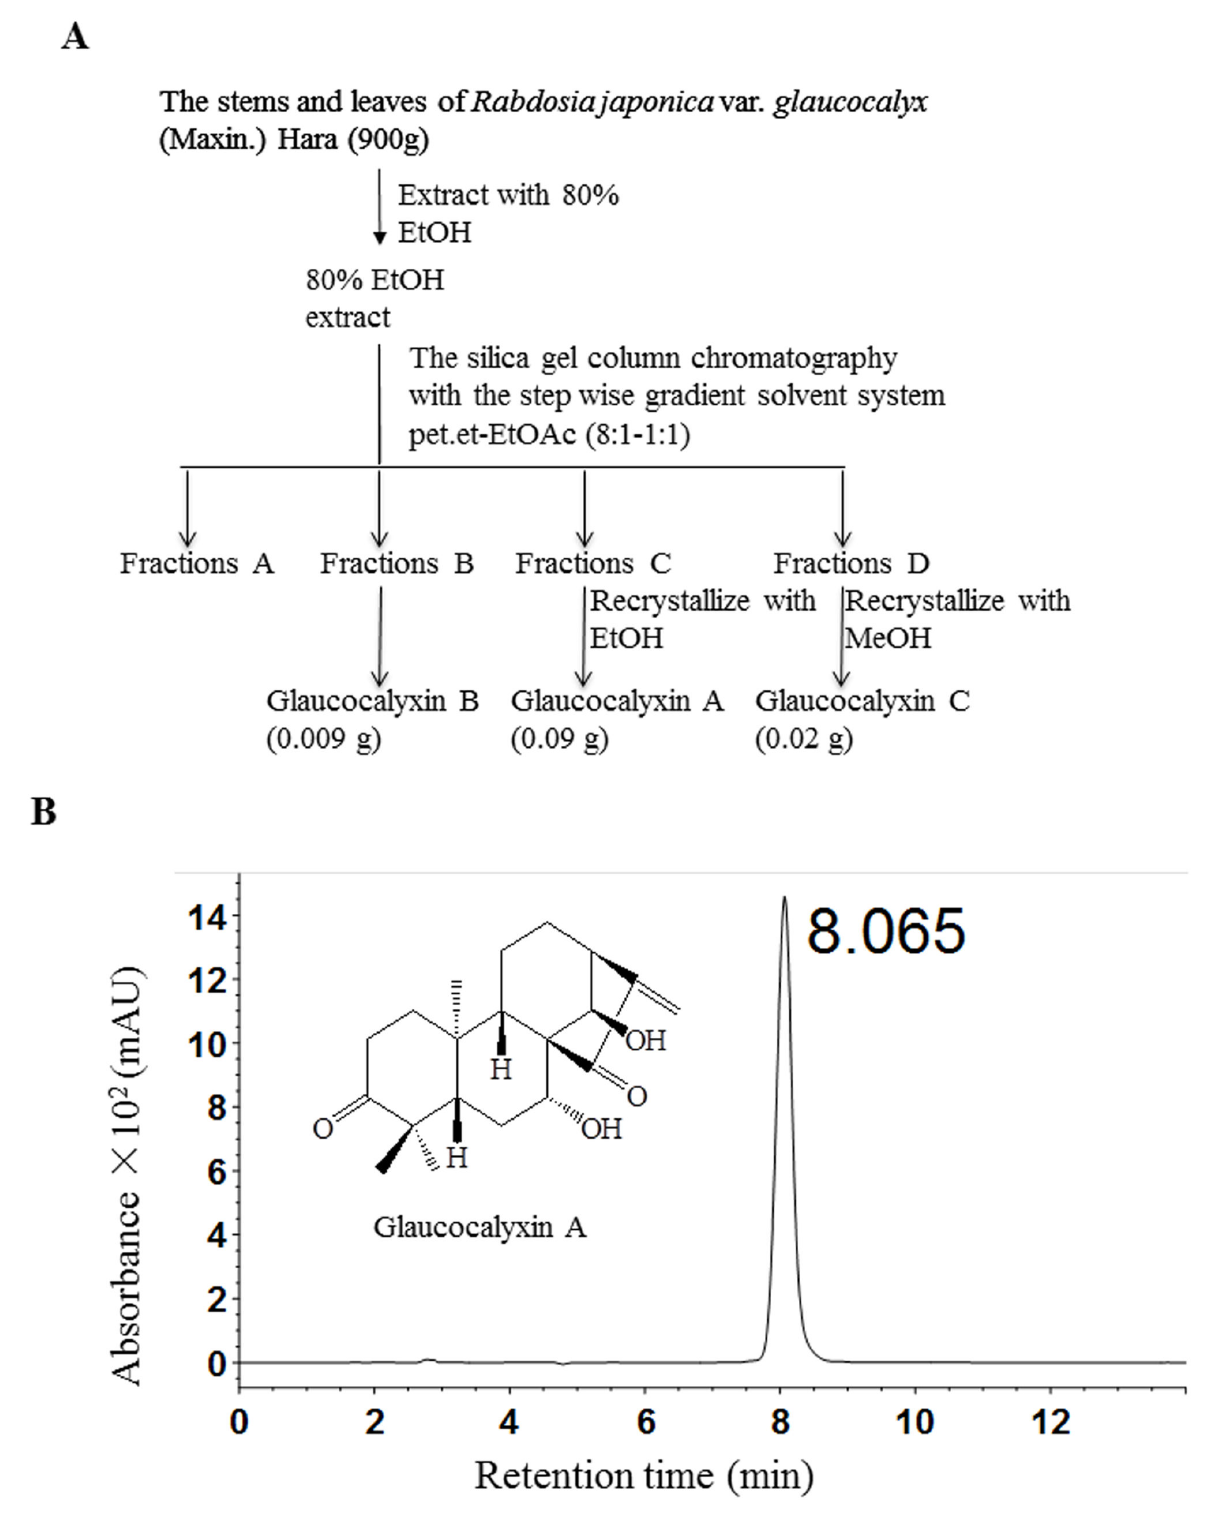
Figure 1. Isolation and identification of Glaucocalyxin A. Rabdosia japonica (Burm. f.) var. glaucocalyx (Maxim.) Hara were chopped and extracted, and the extract was applied to column chromatography. GLA, GLB, and GLC were obtained from the fraction C, fraction B, and fraction D, respectively (A). The isolated GLA was further confirmed by HPLC and its purity is 98% (B). doi: 10.1371/journal.pone.0085120.g001 PLOS ONE |